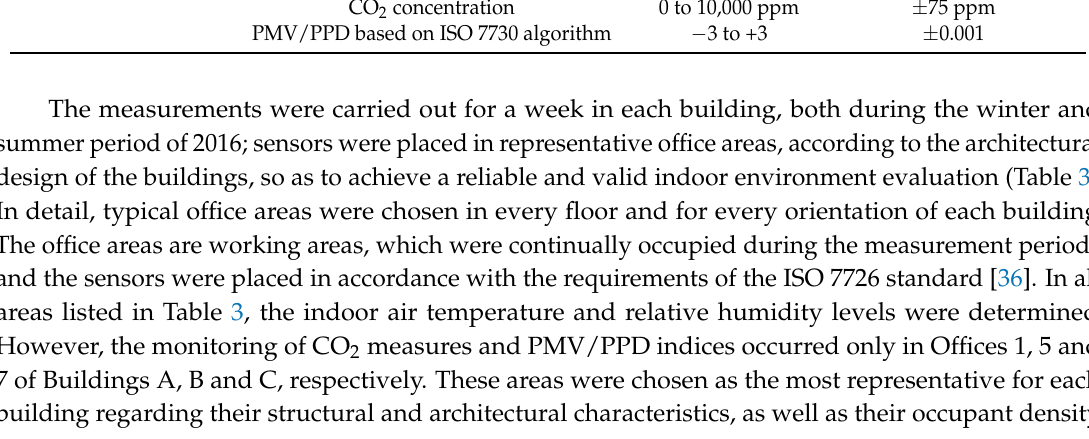
Table 3. Office of data sensor placement in every building under